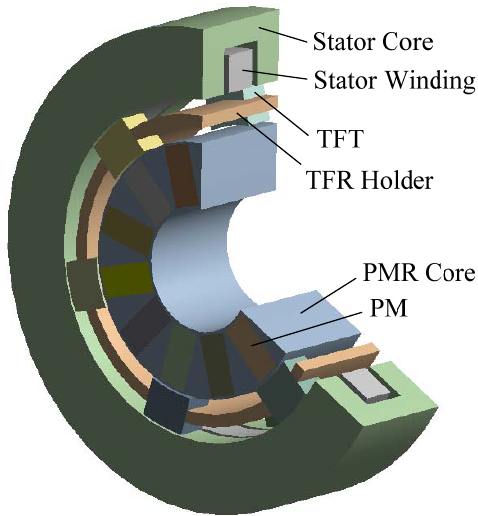
Figure 4. One phase of the